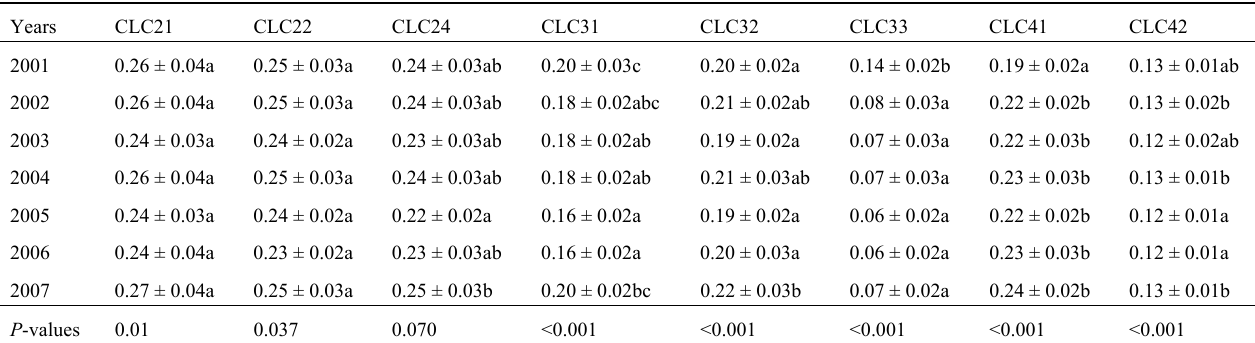
Table 2. Mean (± a standard deviation) annual EVI for 2001 to 2007 of selected CORINE land-covers. P -values result from the one-way ANOVA of EVI time series using years as factor. Lower case letters indicate differences between years and homogeneous subgroups (ANOVA, Tukey test, P <